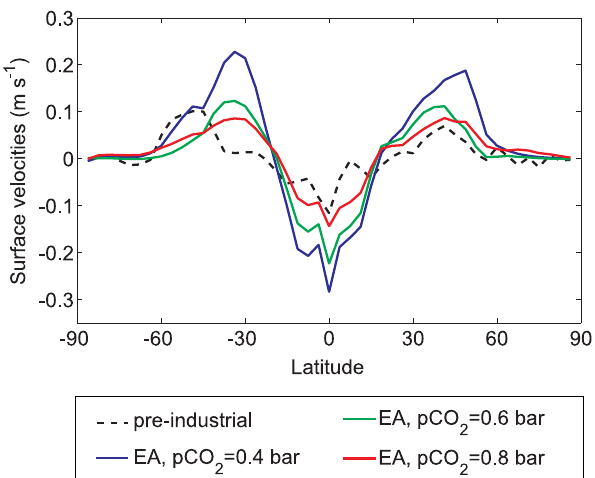
Fig. 15. Oceanic surface velocities (annual and zonal mean) for the pre-industrial climate state as well as the three climate states of the early Archean.